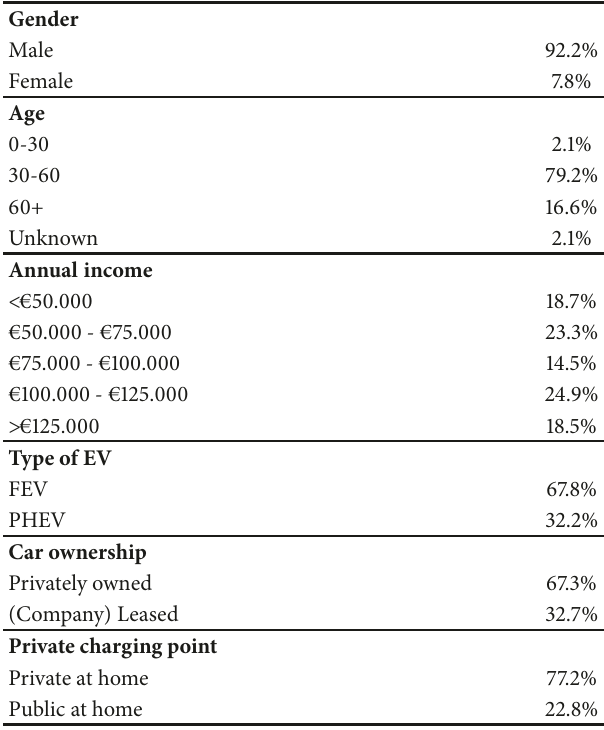
Table 3: Sociodemographic figures of respondents to the